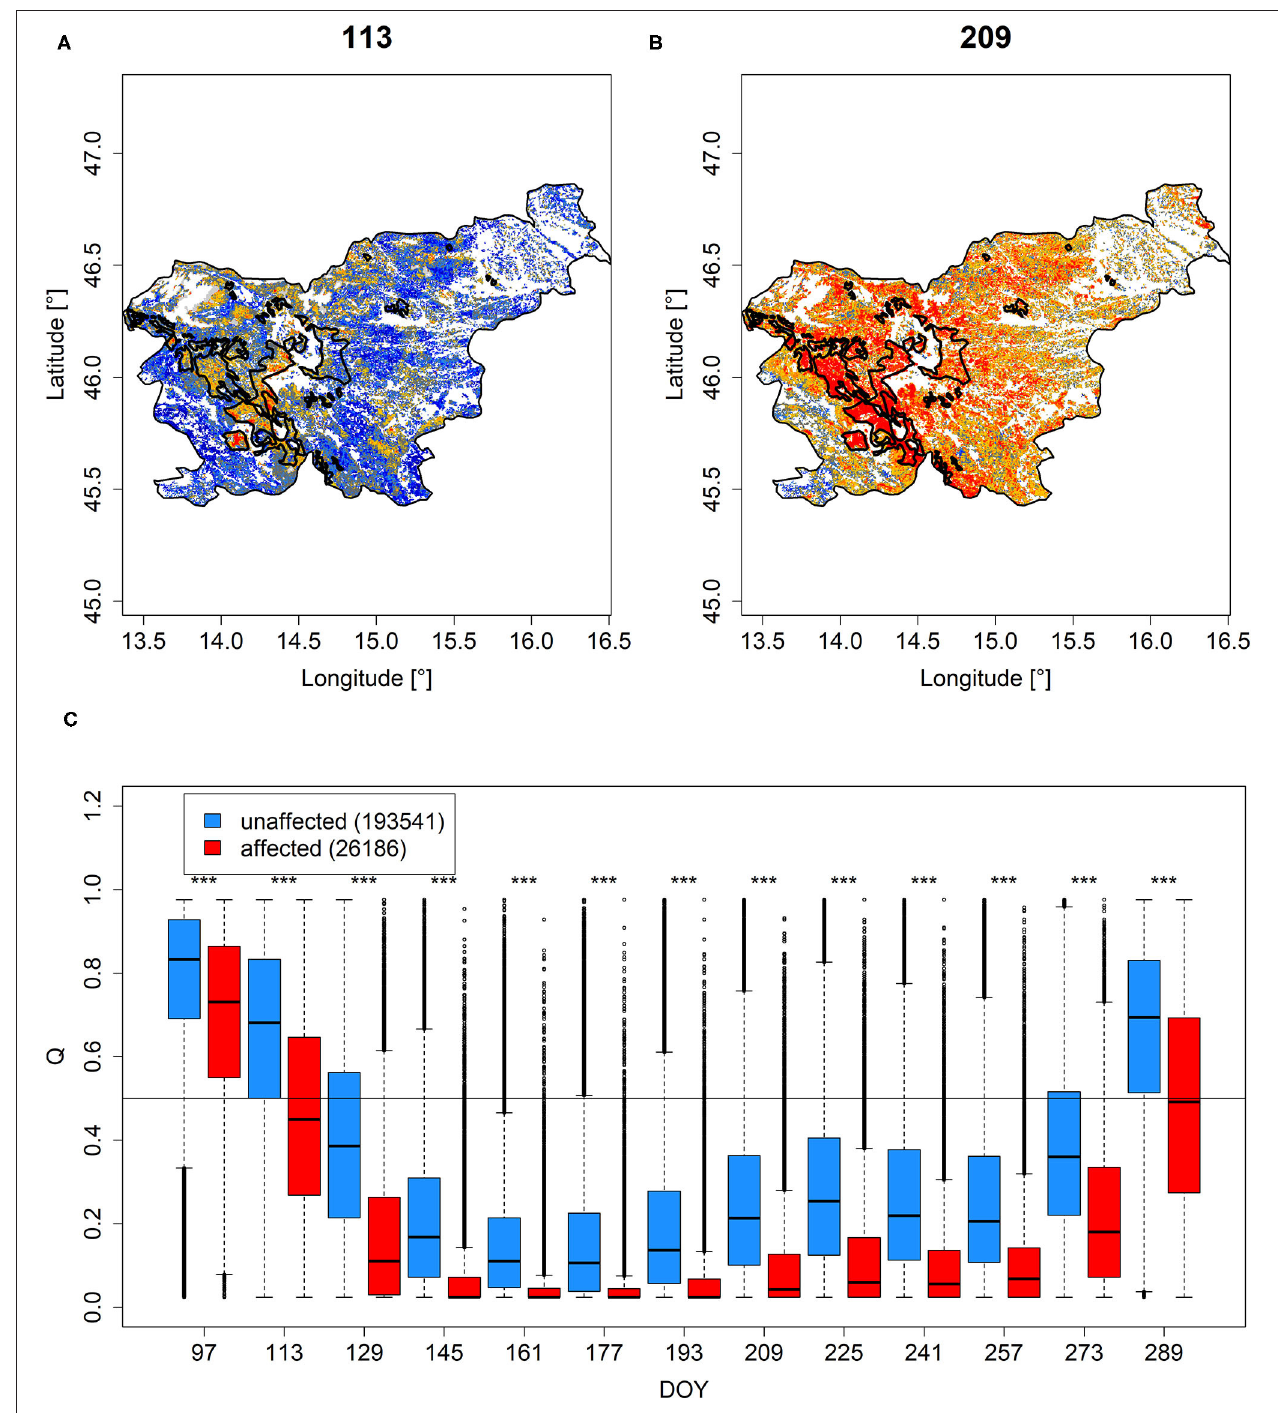
FIGURE 6 | Q mapped for Slovenia on DOY 113 (A) and 209 (B) . The polygons demarcate areas affected by the ice storm according to Roženbergar et al. (2020). Corresponding values grouped according to affectedness from DOY 97 until DOY 289 are shown in (C) . The horizontal line in (C) demarcates median Q values of 0.5. ***Significance stars indicate significant differences between DOY-specific groups according to Wilcoxon rank-sum test. Similar results for PDM are shown in Supplementary Figure 10 .